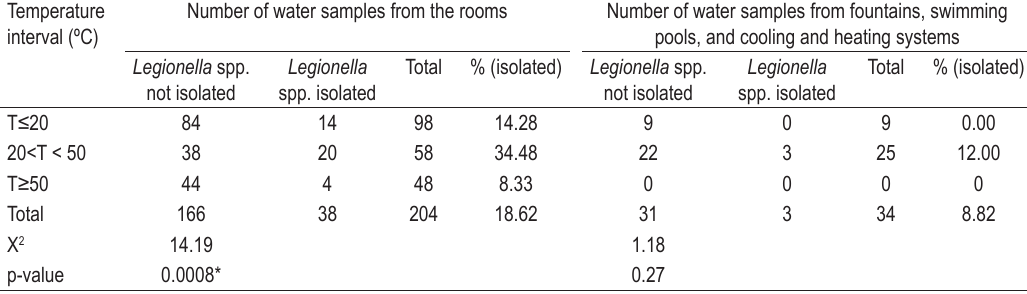
TABLE 2. A compared review of the X 2 test results and differences in the number of positive and negative results against the measured temperature